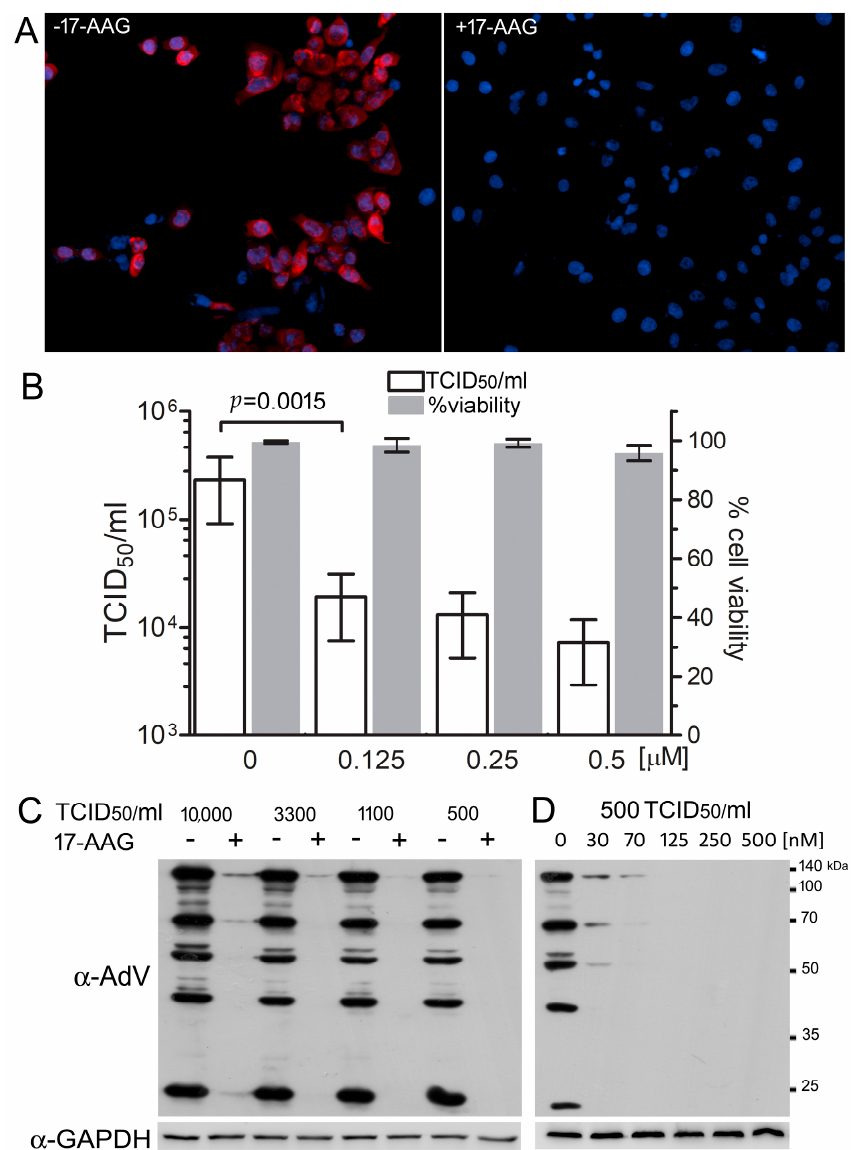
Figure 1. Hsp90 activity is necessary for AdV5 replication. ( A ) Cells A549 were infected with 500 TCID 50 /mL of AdV5 without 17-(Allylamino)-17-demethoxygeldanamycin (17-AAG) (panel A) or with 0.25 µ M 17-AAG (panel B). Cells were stained with anti-human adenovirus 5 (HAdV-5) antibody (red) and DAPI (blue) 24 h after infection. ( B ) A549 cells infected with HAdV-5 were cultured for 48 h in the indicated concentrations of 17-AAG. The yield of the virus was measured using a cytopathic assay. Cell viability after 72 h of culture in the same 17-AAG concentrations was measured using MTT assay. Plotted are TCID 50 and 95% confidence intervals values for the virus yield, and mean and SD values for the cell viability, and p value was calculated using one-tailed student’s t -test. ( C ) A549 cells infected with indicated concentration of HAdV-5 were cultured in 0.25 µ M 17-AAG or without the inhibitor for 24 h. ( D )A549 cells infected with 500 TCID 50 /mL of HAdV-5 were cultured in the indicated concentrations of 17-AAG for 24 h. Protein extracts were analyzed by western blot with anti-HAdV-5